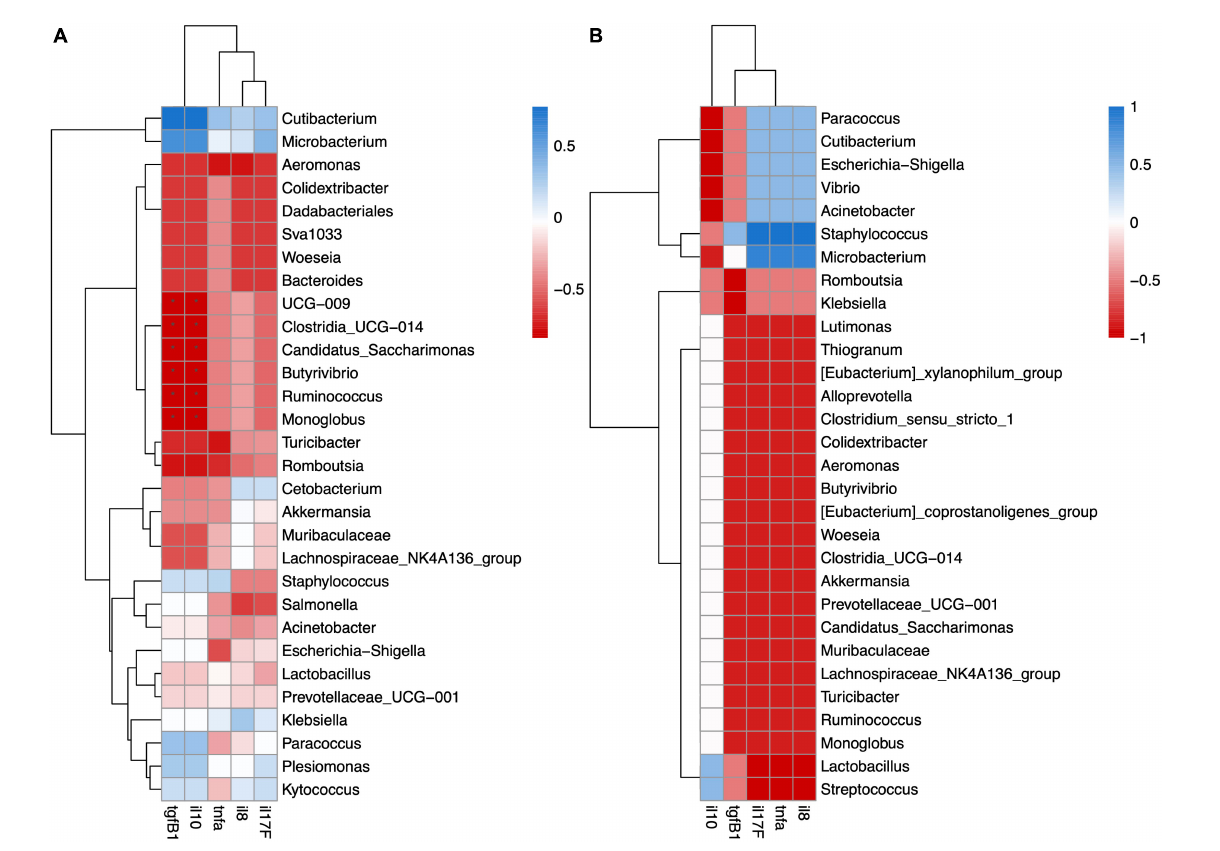
FIGURE6 Spearman correlation analysis revealed significant positive or negative relation between cytokine gene expression and mucosa-associated microbiota in (A) FW and (B) SW